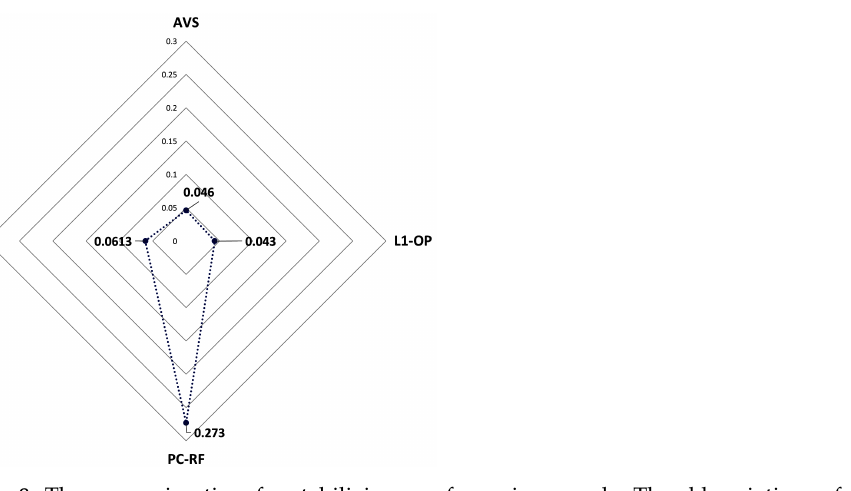
Figure 8. The processing time for stabilizing one frame in seconds. The abbreviations of method names are defined in Section 3.2 just for referencing